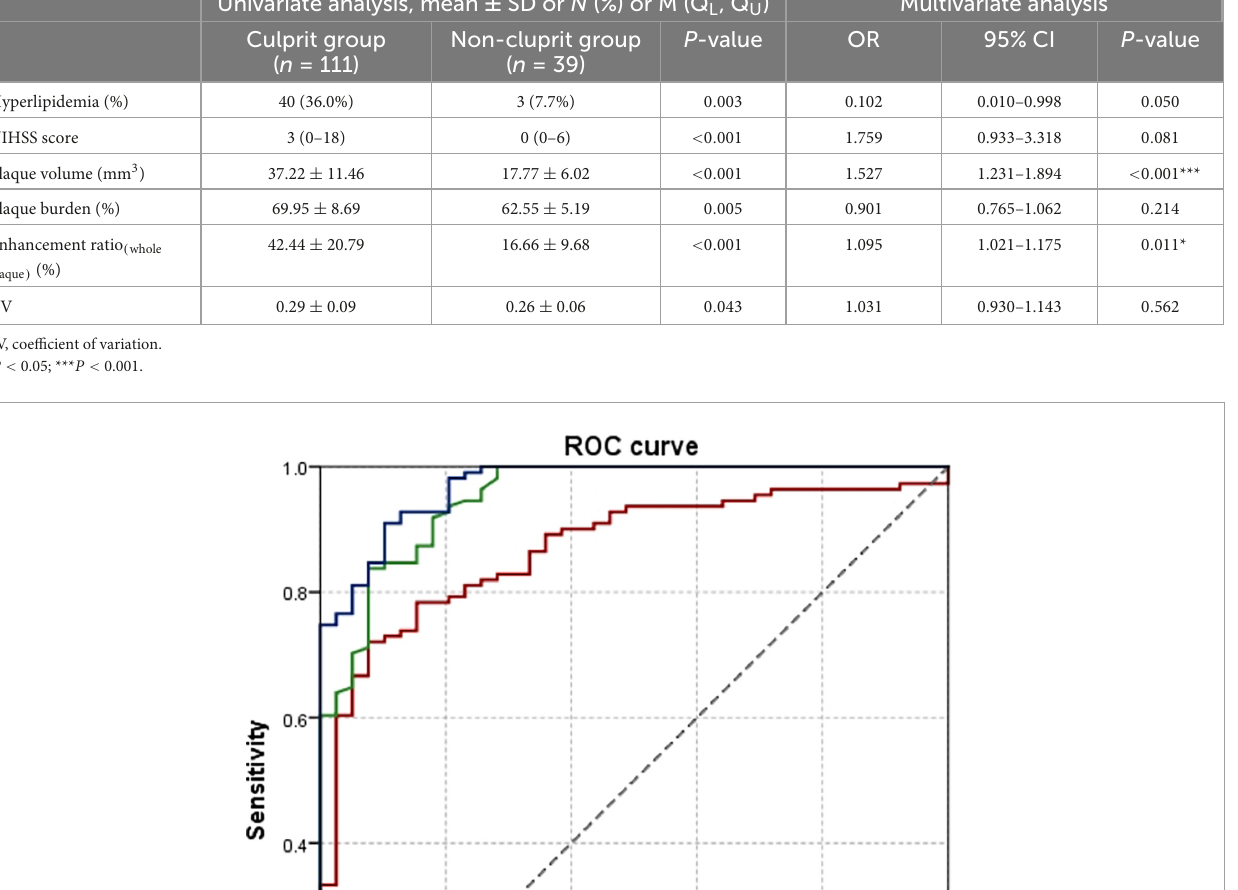
TABLE 3 Univariate and multivariate analyses of the characteristics and histogram features associated with culprit plaques. Univariate analysis, mean ± SD or N (%) or M (Q L , Q U ) Multivariate analysis